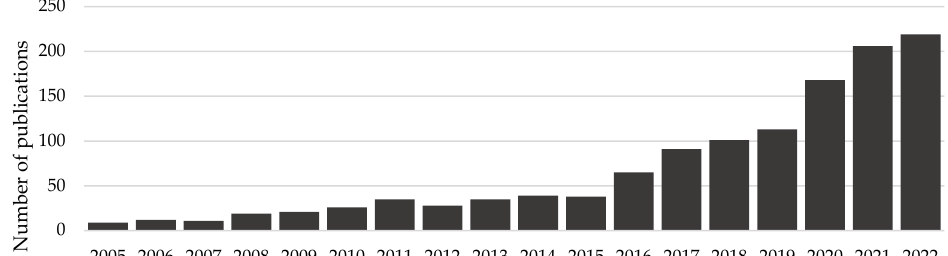
Figure 2. Number of scientific articles published on the PubMed database from 2005 to 2022 upon the search for “probiotic” and “biofilm” keywords.